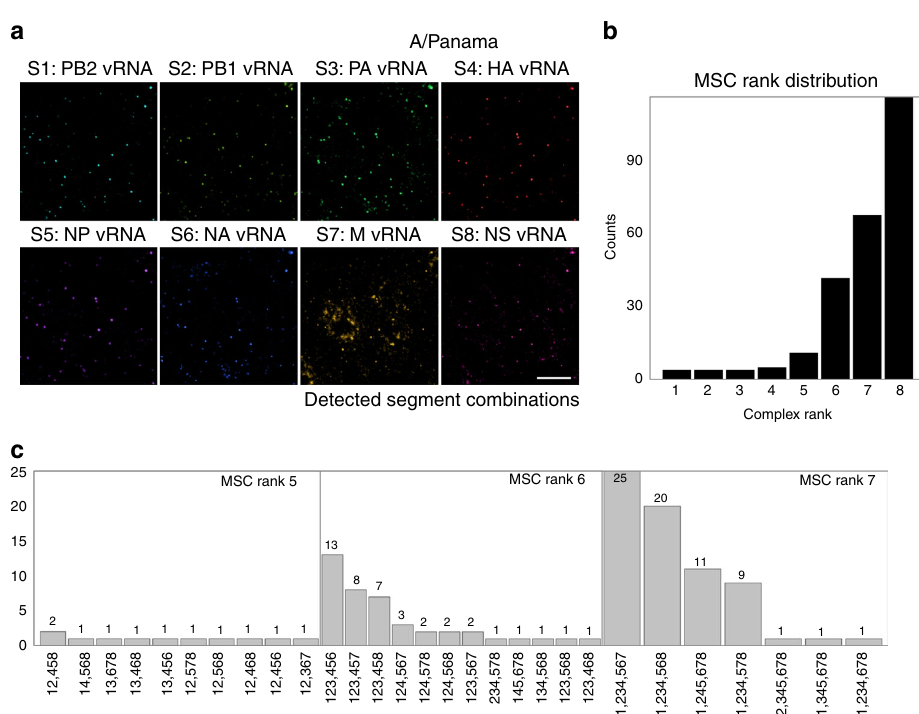
Fig. 5 Viral ribonucleoproteins (vRNP) composition of intact A/Panama virions. Virions were bound to A549 cells, and subsequently, virus-cell complexes were fi xated. Viral RNA (vRNA) segments (S) were stained by fl uorescence in situ hybridisation (FISH) with Atto550-coupled FISH probes. a Fluorescence images represent max z projections. Colours are identical to Fig. 2. Data were obtained from three independent experiments. Scale bar corresponds to 10 µ m. b Histogram of all detected spots and their respective MSC ranks, same formatting as Fig. 3, black bars. c MSC distribution for ranks 5 – 7, same formatting as Fig. 4. Bars represent the number of observed MSCs of the respective combination. N = 1653 spots. Source data are provided as a Source Data fi